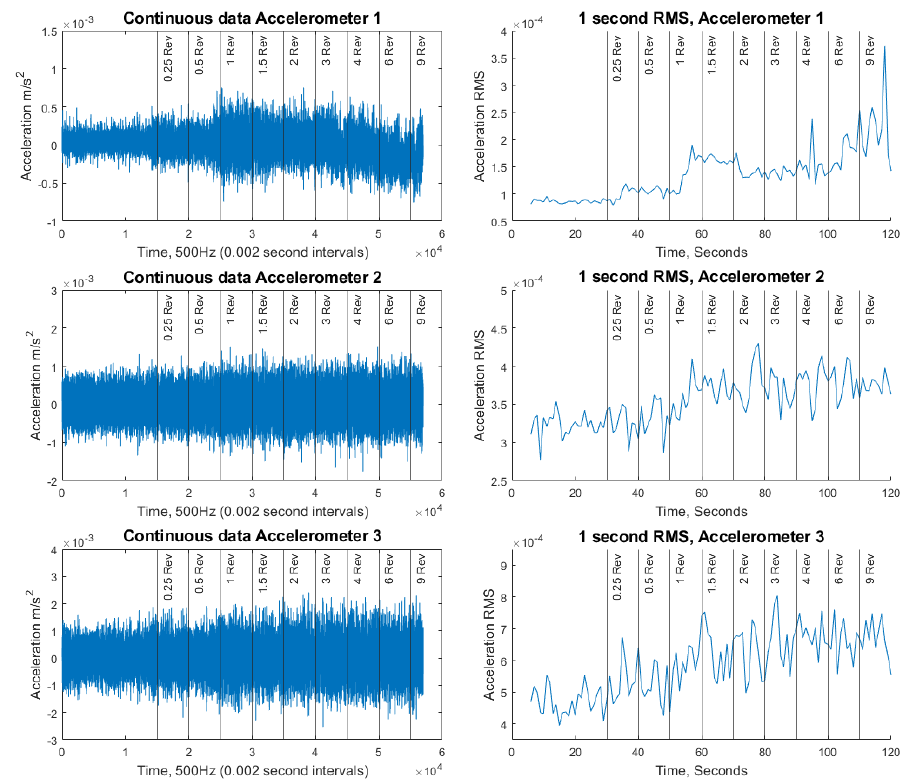
Figure 13. Raw accelerometer data and 1 s RMS for continuous recording of progressive bolt loosening for all accelerom- eters.